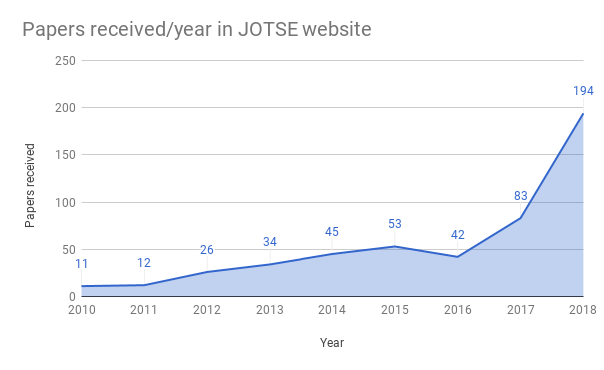
Figure 1. JOTSE's